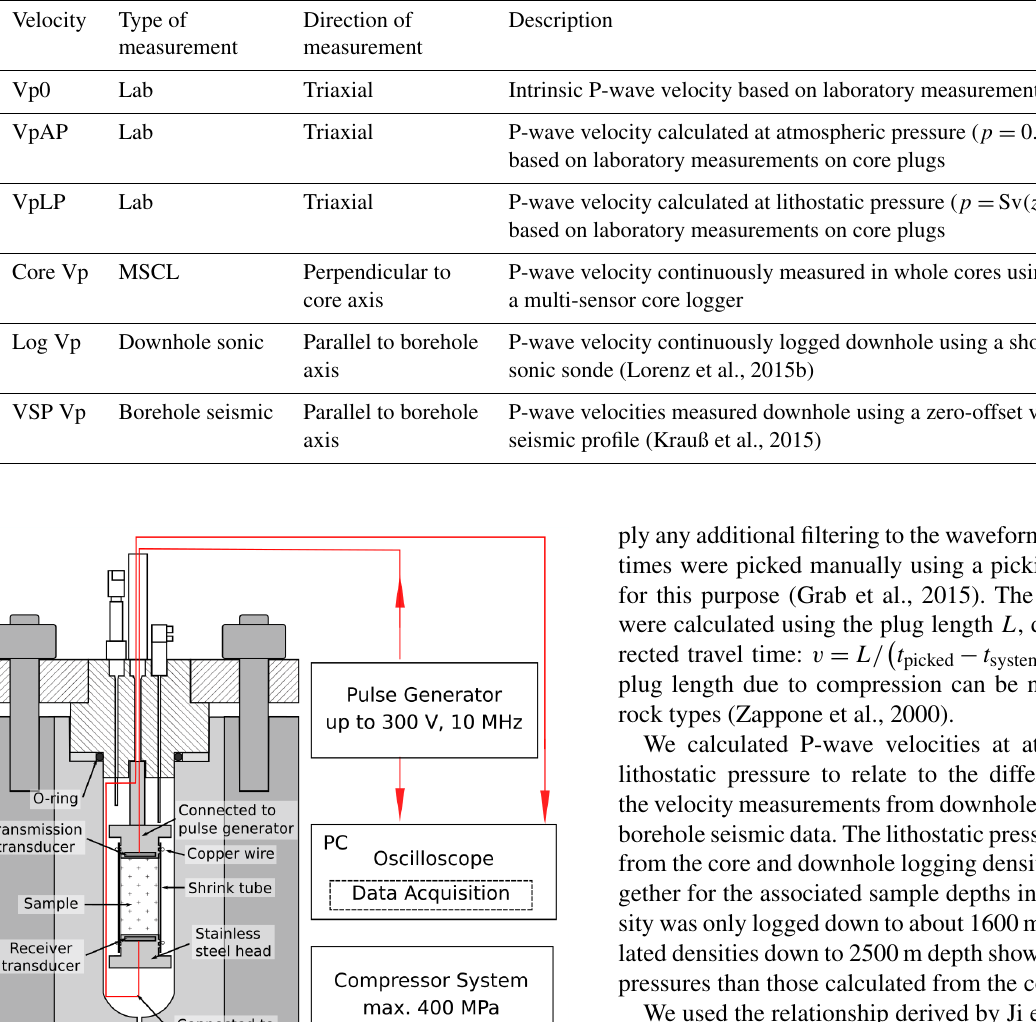
Table 1. Overview of velocity nomenclature used in this study. The laboratory measurements were carried out on three mutually perpendicular core plugs. See text for details.